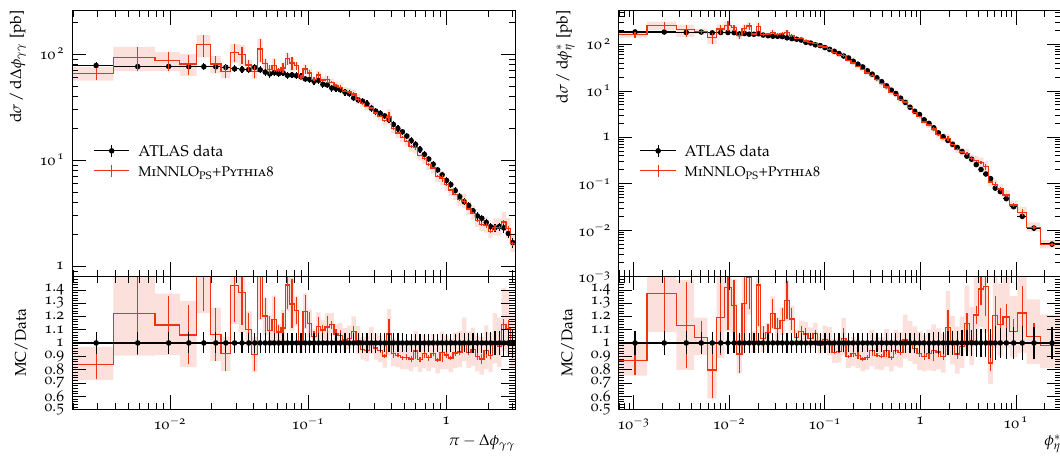
Figure 11 . Comparison between the ATLAS data and the distributions obtained with MiNNLO Pythia8 , for the azimuthal separation of the two photons ∆ φ PS + defined in eq. (4.2). Scale-variation bands are also shown, together with the statistical errors of the central